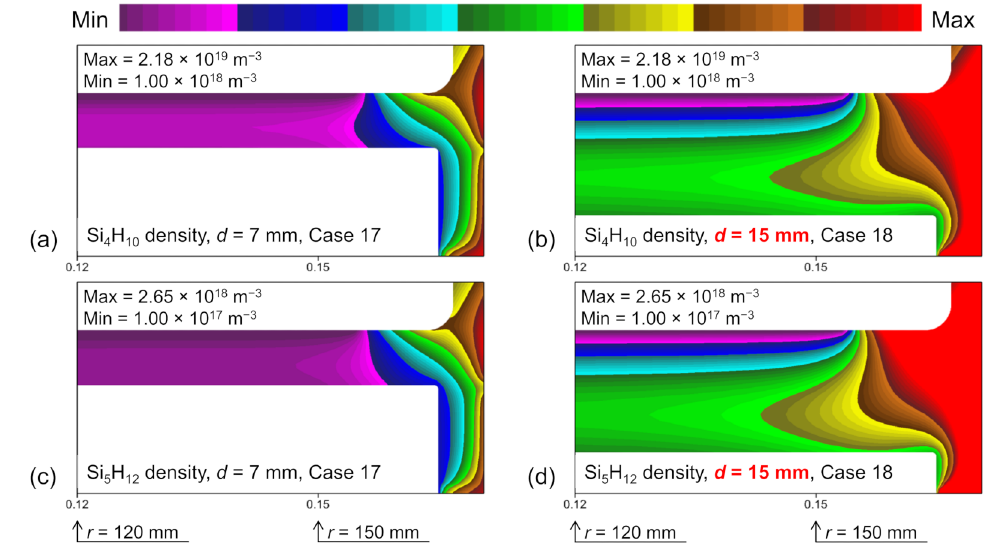
Figure 9. Contour plots of the spatial profiles of the time-averaged Si 4 H 10 density (m − 3 ) for ( a ) Case 17 ( d = 7 mm) and ( b ) Case 18 ( d = 15 mm) for r ≥ 120 mm. Contour plots of the spatial profiles of the time-averaged Si 5 H 12 density (m − 3 ) for ( c ) Case 17 ( d = 7 mm) and ( d ) Case 18 ( d = 15 mm) for r ≥ 120 mm. The profiles are radially uniform for r < 120